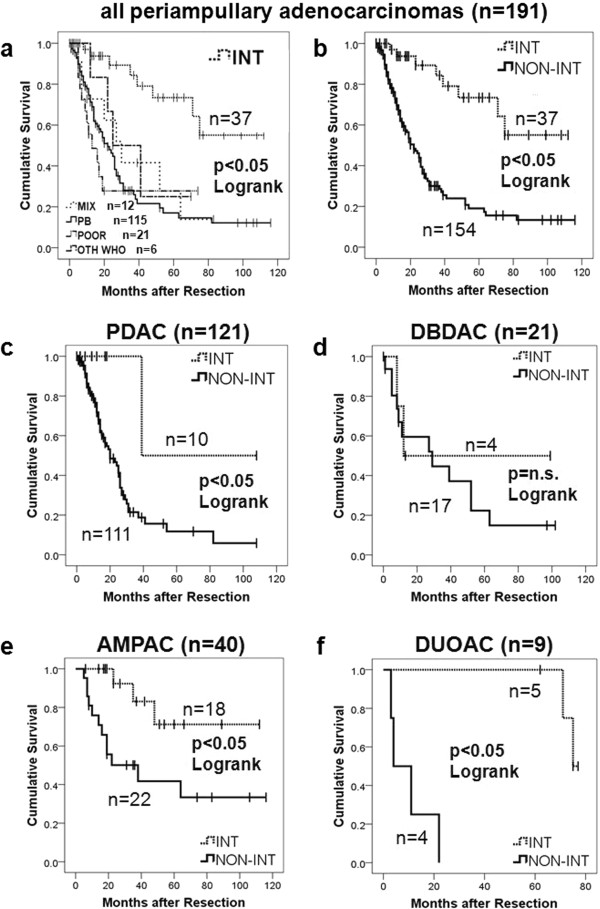
Survival plots according to histological subtypes and tumor origin. a: KM plot for all patients with periampullary adenocarcinomas, stratified for histological subtypes. b: KM plot for all patients with periampullary adenocarcinoma, stratified for INT versus non-INT subtype. c-f: KM plots for INT versus non-INT histological subtype divided by respective periampullary adenocarcinoma origin (pancreatic head (PDAC), ampullary (AMPAC), distal bile duct (DBDAC), duodenal (DUOAC). perioperative deaths (n = 7) excluded, p values derived from two-sided Logrank test. For details see also Table 4. Abbreviations: KM Kaplan Meier, INT intestinal type adenocarcinoma, PB pancreatobiliary type adenocarcinoma, MIX mixed type adenocarcinoma, POOR poorly differentiated carcinoma, OTH other WHO types. n.s. not significant.